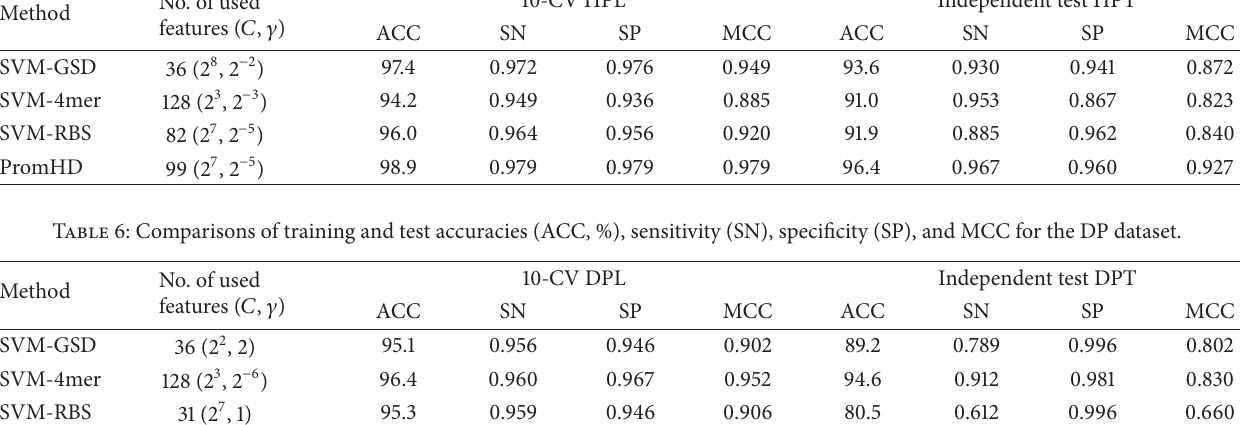
Table 5: Comparisons of training and test accuracies (ACC, %), sensitivity (SN), specificity (SP), and MCC for the HP dataset. Method